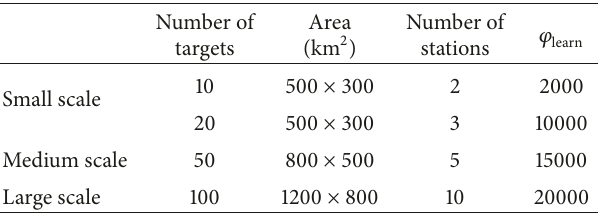
Table 4: Value of parameters for the